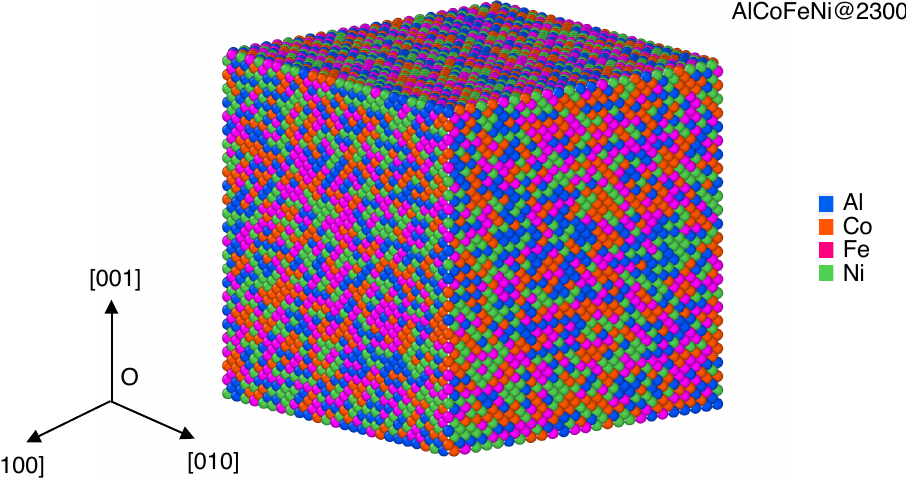
Figure 3. Atomic configuration of AlCoFeNi at 2300 K. Al, Co, Fe, and Ni atoms are indicated with blue, orange, purple, and green spheres,